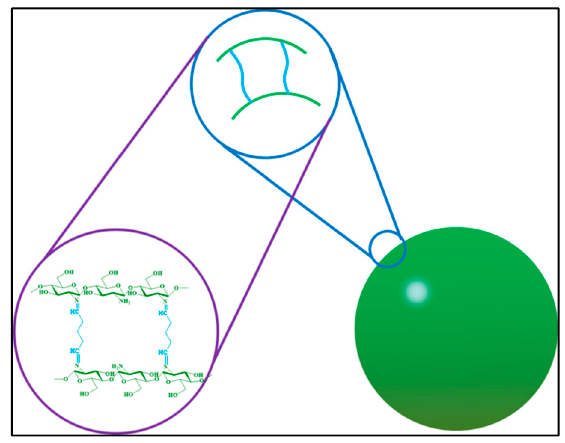
Figure 1. Emulsification cross-linking schematic.